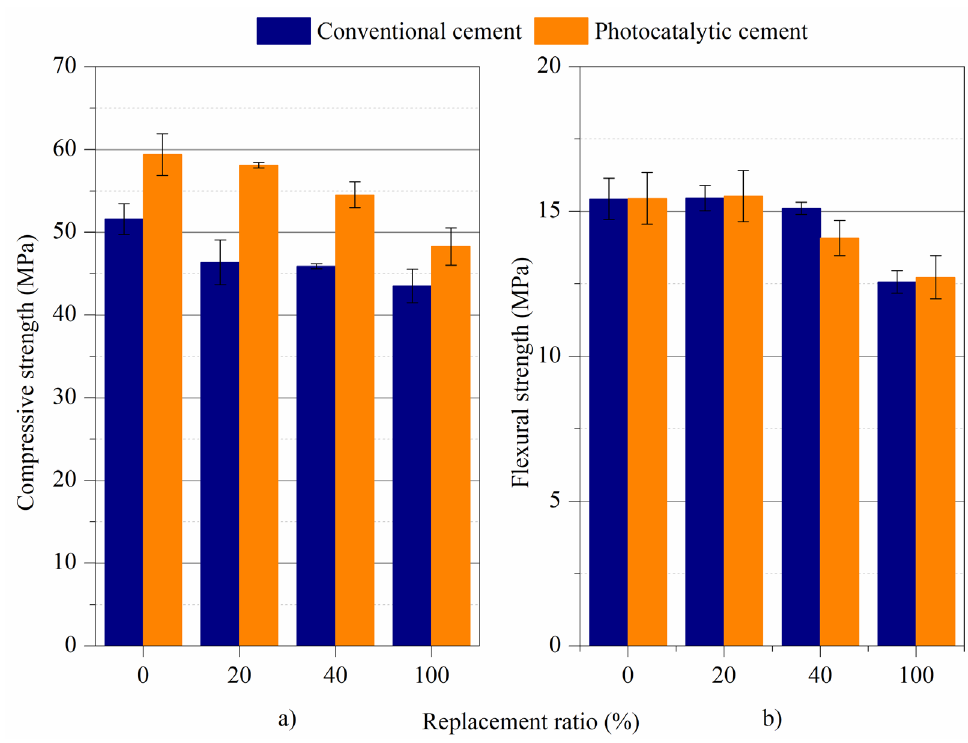
Figure 2. Mechanical strength comparison: ( a ) compressive strength; ( b ) flexural strength.